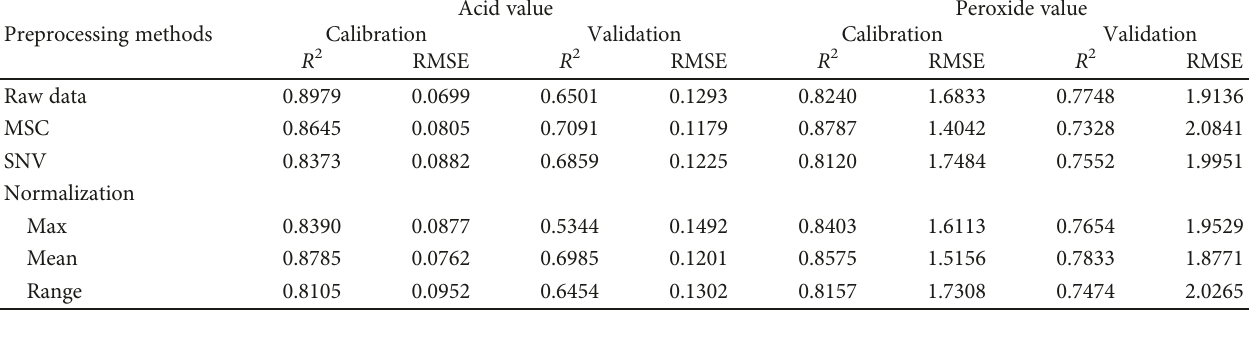
Table 3: Results of PCR calibration and validation for acid and peroxide values of perilla seed oil according to preprocessing methods. Preprocessing methods